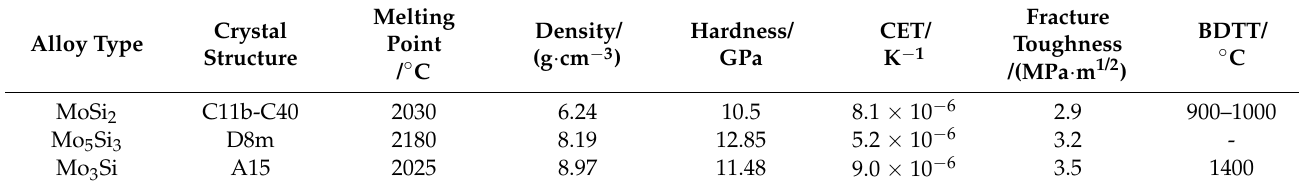
Table 4. Mo-Si intermetallic phase crystallography and physical parameters